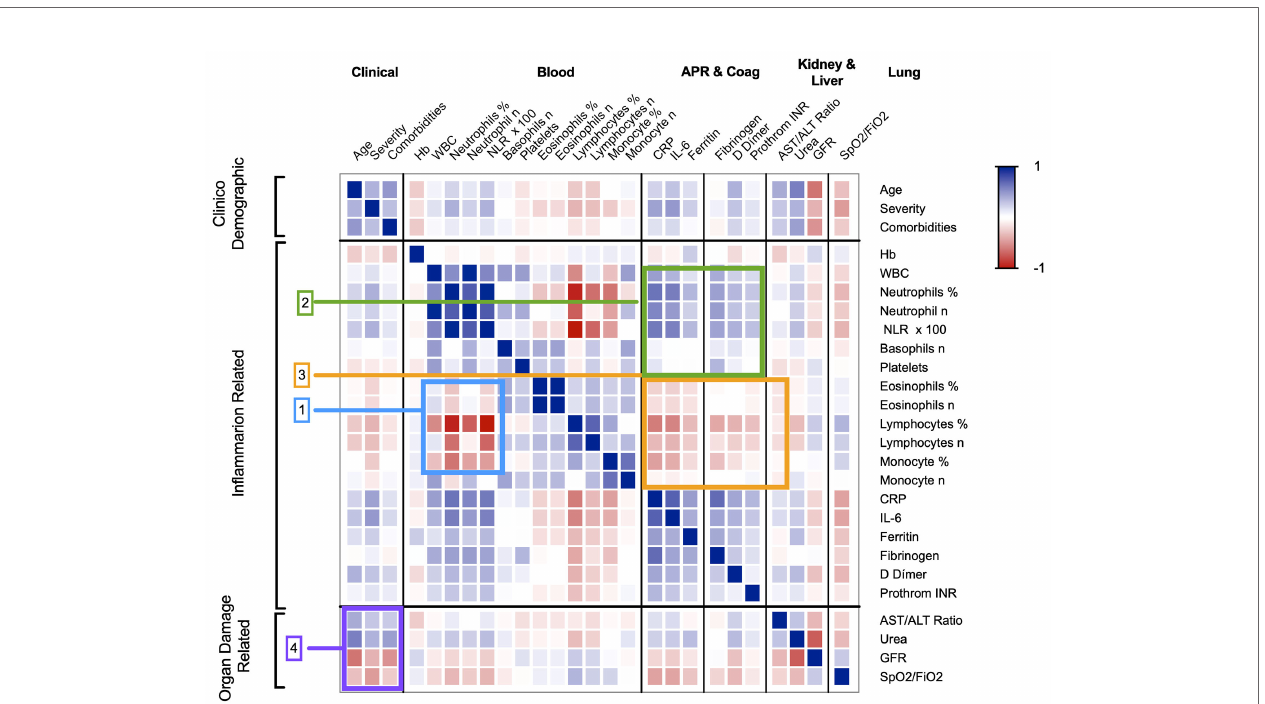
FIGURE 4 | Overall correlograms of selected data on demographics and clinical laboratory variables that were organised in categories. [1] The blue rectangle highlights the negative correlation between neutrophils and the cluster of lymphocytes, monocytes, and eosinophils. [2] The green rectangle highlights the blood cell variables that correlate positively with the acute-phase reactants (APRs) and coagulation factors. [3] The orange rectangle highlights the negative correlation between lymphocytes, monocytes, and eosinophils with APRs and coagulation factors. [4] The magenta rectangle highlights the correlations between age, disease severity, comorbidities with liver and kidney function and SpO 2 /FiO 2 . The cells following the diagonal highlights the seven families of variables: clinical, blood cells, APR-coagulation, liver, kidney and lung tests, which show the expected strong correlations among themselves. The thick lines between rows separate the main categories. APR, acute-phase reactants; SpO 2 /FiO 2 , oxygen saturation/fraction of inspired oxygen; NLR, neutrophil-to-lymphocyte ratio; CRP, C-reactive protein; AST, aspartate aminotransferase; ALT, alanine aminotransferase; GFR, estimated glomerular fi ltration rate. The r- and p-values of the data represented in the heatmap are in xlsx format fi les in the supplementary material “ Correlation of variables, r-values ” and “ Correlation of variables, p-values ” . TABLE 4 | Bivariate age adjusted logistic regression for 28-days survival/decease and non-severe/severe outcomes. 28d decease outcome age adjusted 28 maximal severity age adjusted